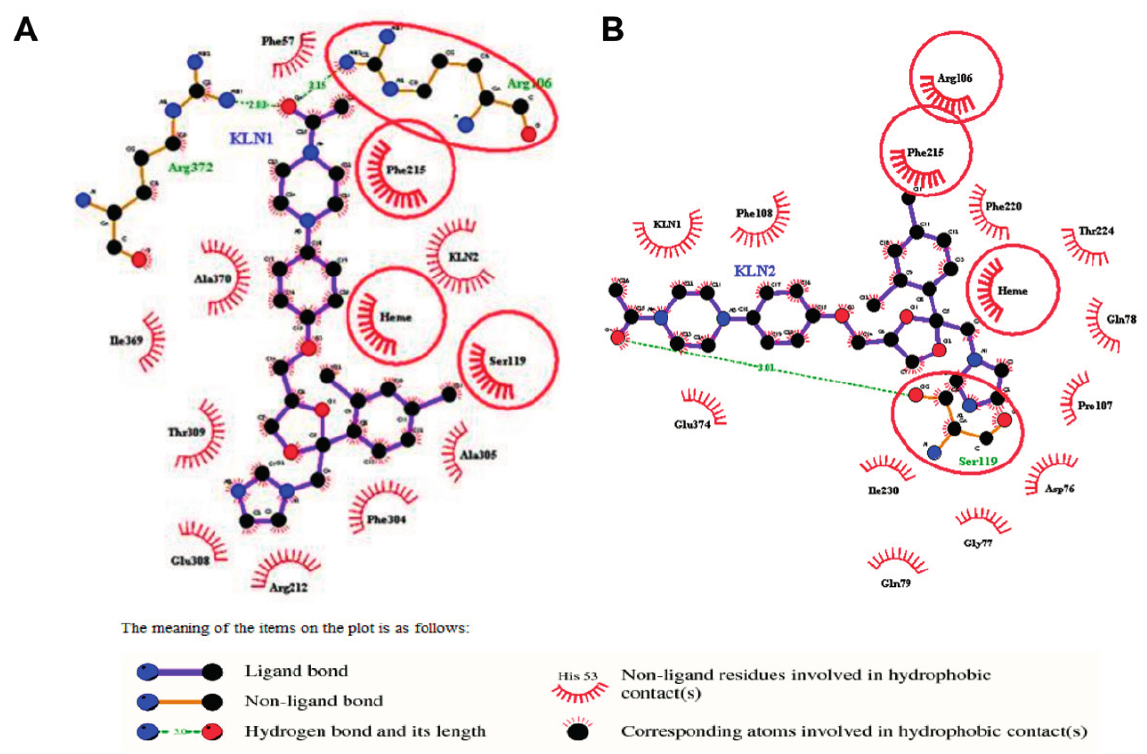
Figure 2. 2D-diagram of the detailed binding information for the ( A ) normal and ( B ) cooperative binding model of CYP3A4t structure. The first KLN binding in the active site was labeled as KLN1, and the second one as